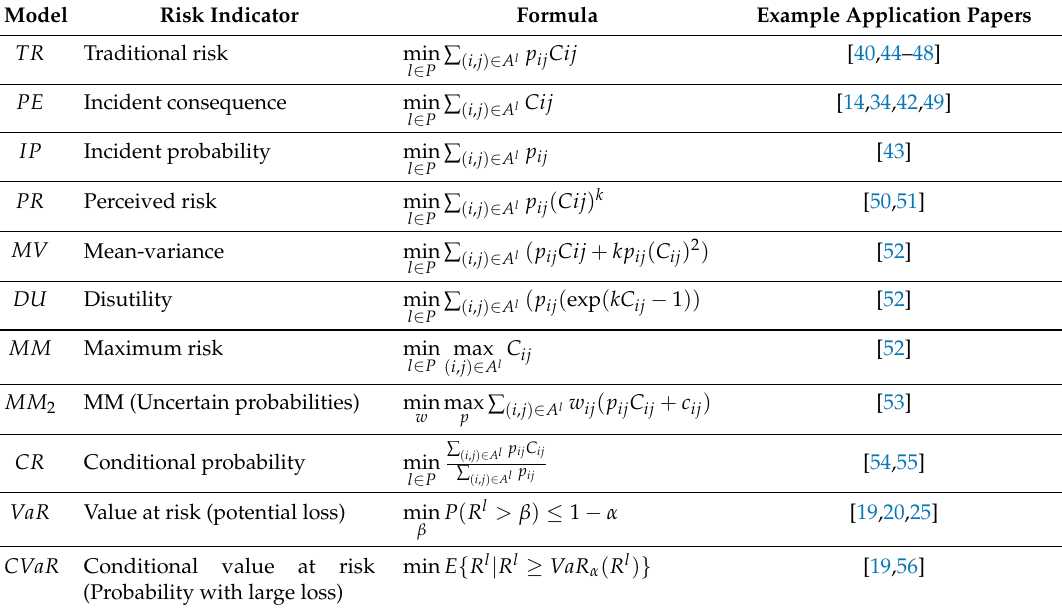
Table 1. An overview of hazmat risk models, their indicators, formulations, and application problems.